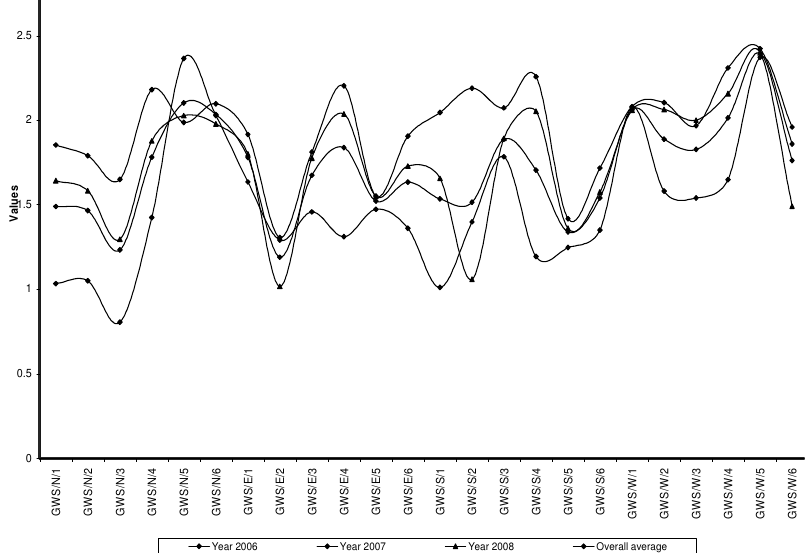
Figure 1. Calculated values of Langelier saturation index